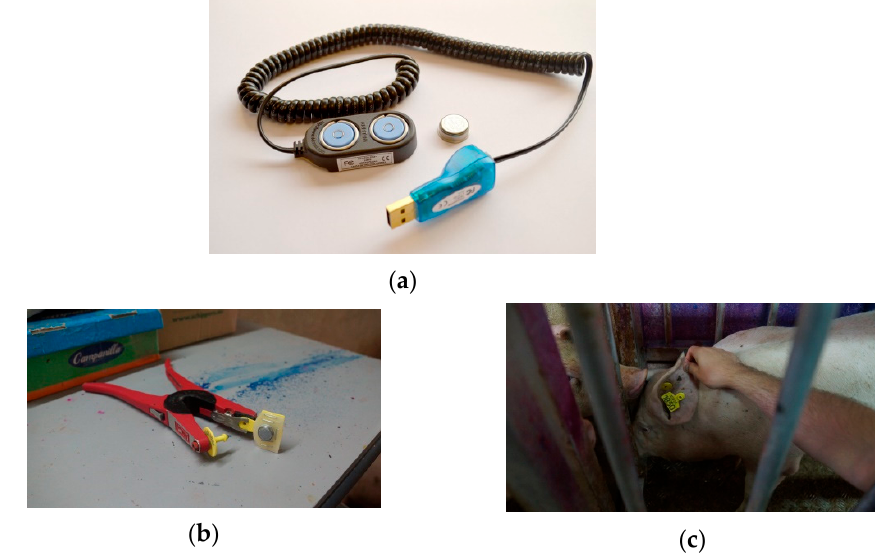
Figure 2. ( a ) DS1992 iButton sensor and DS1402D-DR8 reader; ( b ) detail of the coupling of the iButton sensor to the barcode tag; and ( c ) installation of the tag with the sensor attached to the animal to be